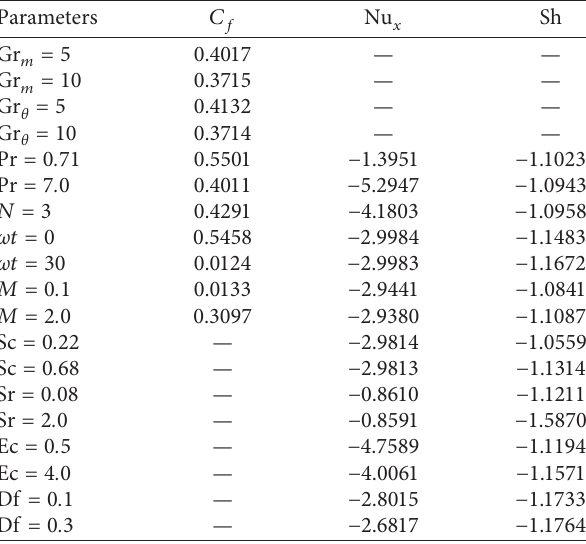
Figure 18: Effects of Dufour number on temperature profile. Table 4: Values of Nusselt number, Sherwood number, and skin